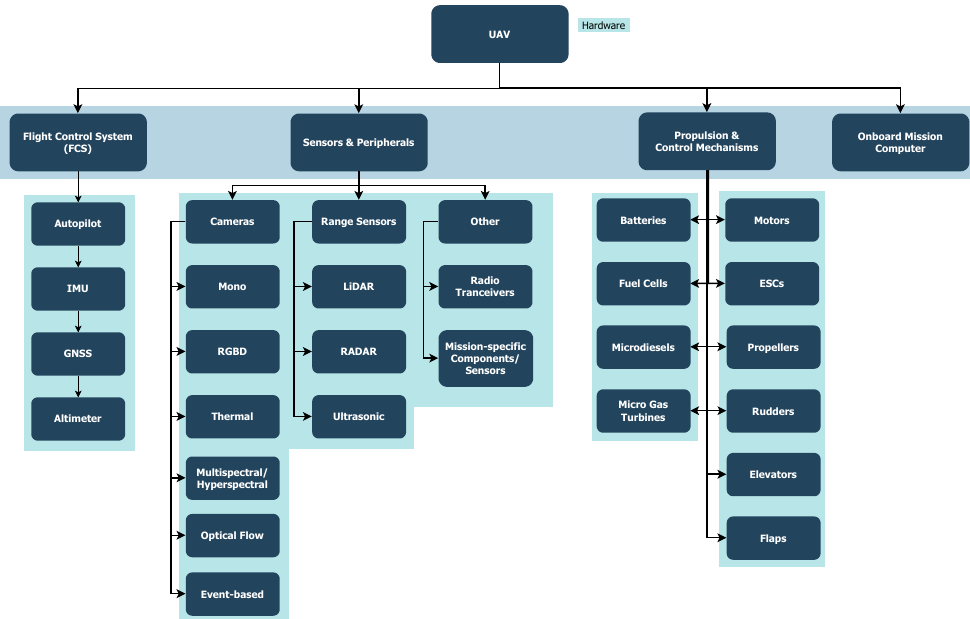
Figure 2. System architecture showing hardware components commonly used with